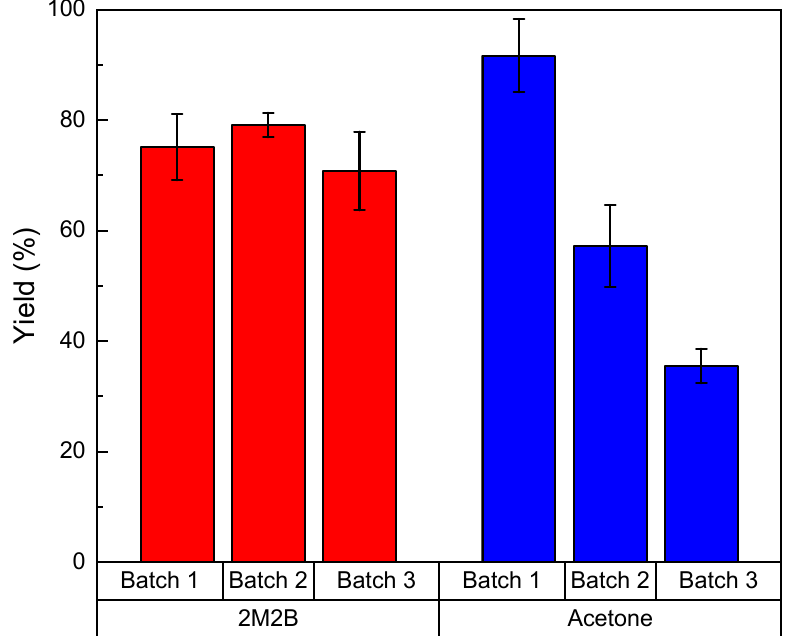
Figure 4. Operational stability of Lipozyme ® 435 in the synthesis of ascorbyl palmitate at 55 °C in 2-methyl-2-butanol and acetone media. Results are depicted as mean ± standard deviation.